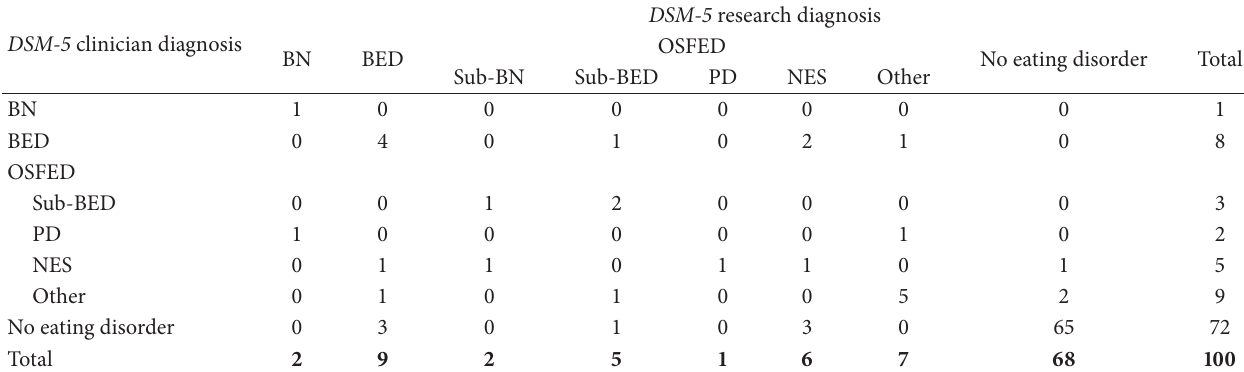
Table 5: Eating disorder diagnoses conferred by structured interview for DSM-5 field trial versus routine clinical interview in an outpatient weight-loss seeking sample.